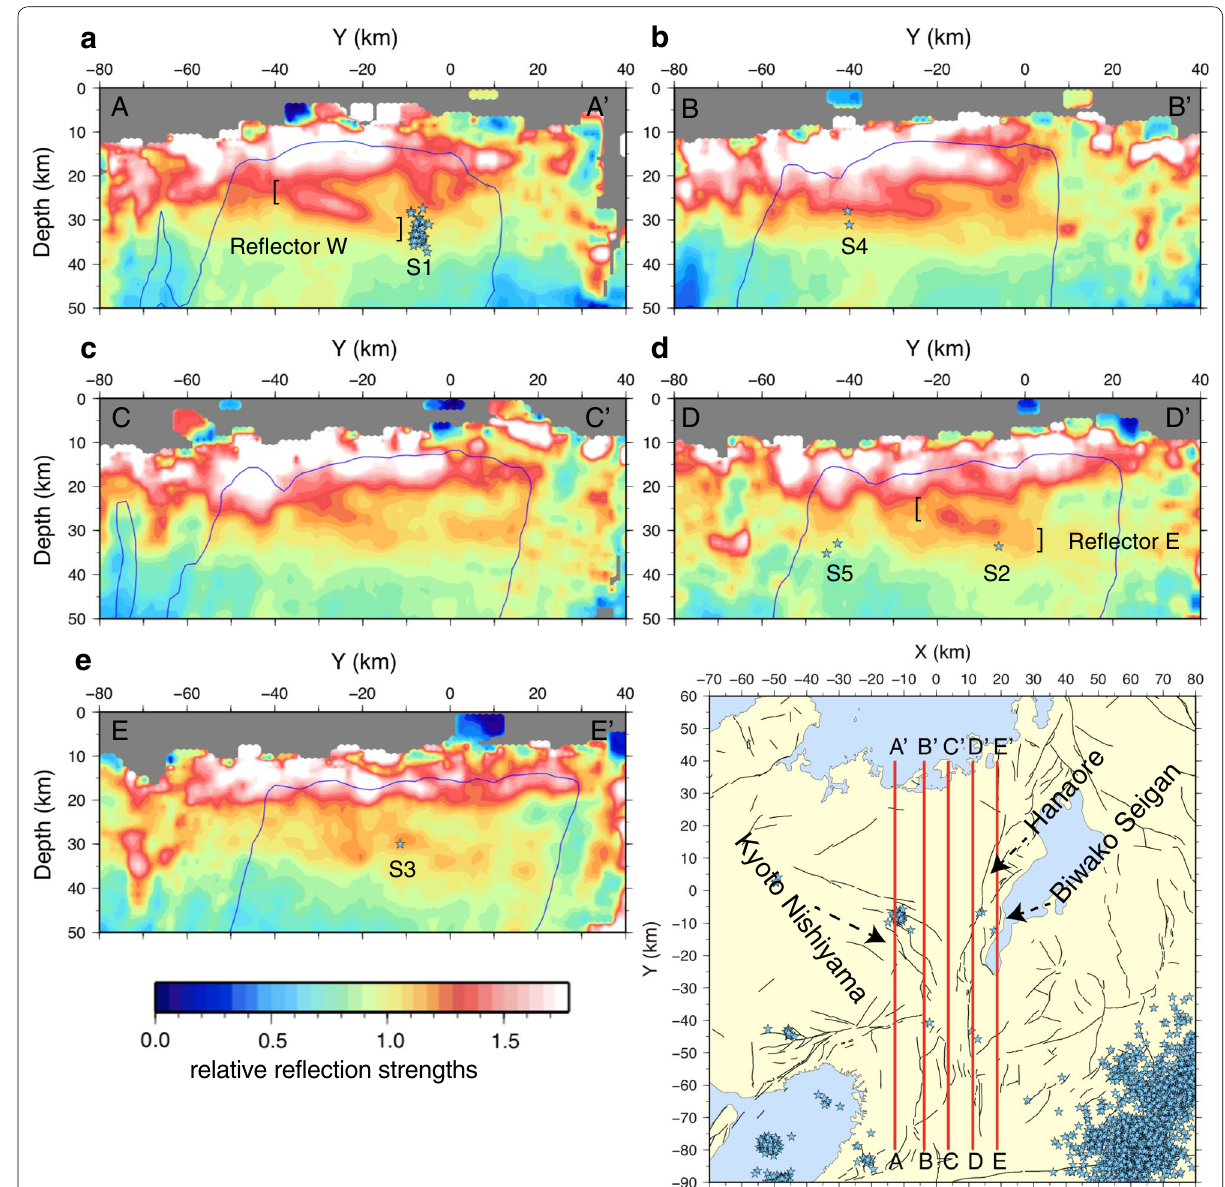
Fig. 4 Relative reflection strengths along NS vertical cross section. The locations of cross sections are shown in the lower right-hand side of the figure. Hypocenters of DLFs occurring within 5 km of each plane are plotted as blue stars. Black lines represent active faults. The assumed angle of inclination is shown at the upper left-hand side of each panel. Blue lines show areas in which the number of data points assigned to each grid cell exceeds 10,000. We consider that relative reflection strengths within blue lines are sufficiently accurate. The names of the fault zones [Kyoto Nishiyama, Hanaore, and Biwako Seigan] are putted near each fault zone in the inset